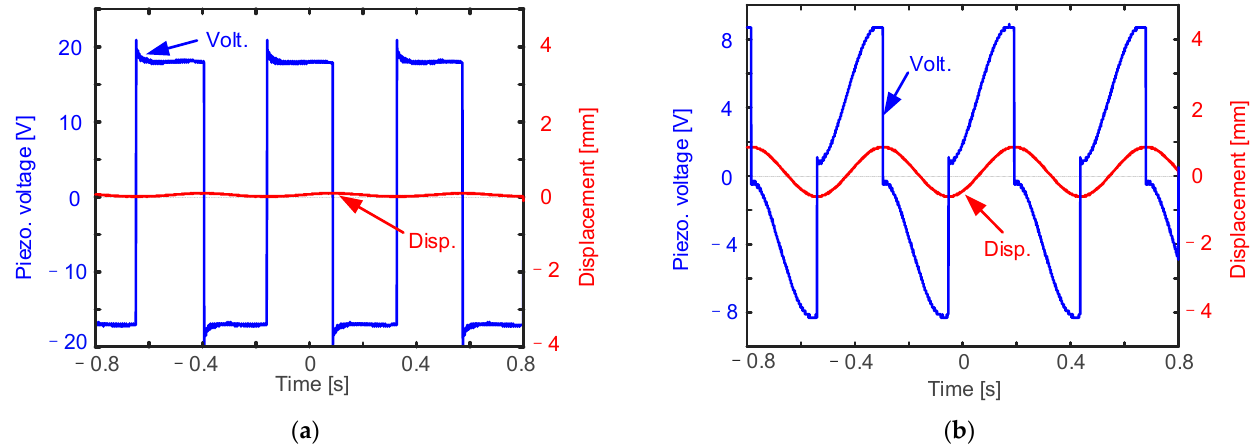
Figure 12. Experimental results of the “suppress vibration and fill vacancy” function: ( a ) injecting energy to suppress vibration; ( b ) extracting energy to fill vacancy.